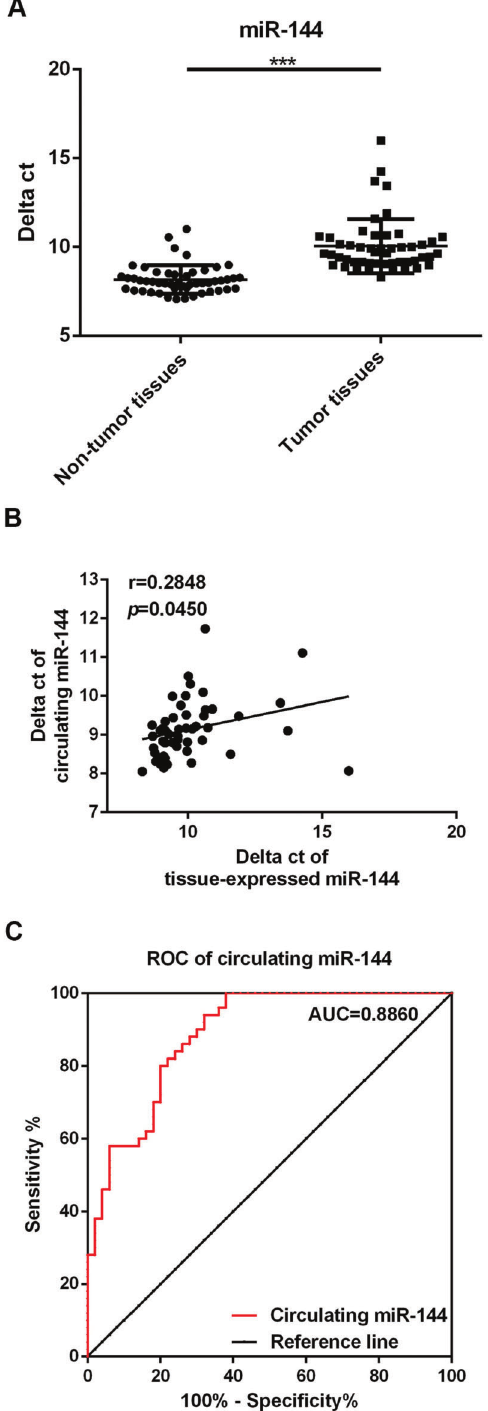
Figure 3 - Decreased miR-144 expression in the serum of retinoblastoma (RB) patients. A. Comparison of miR-144 levels in serum of RB patients and healthy controls. B. Correlation between miR-144 levels in RB tumor and serum samples of RB patients. C. Results of receiver operating characteristic (ROC) analysis for circulating RB. ** p o